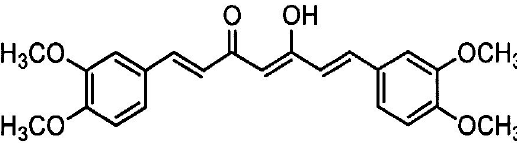
Figure 1. Chemical structures of curcumin. Curcumin is derived from the rhizomes of turmeric ( Curcuma longa ).